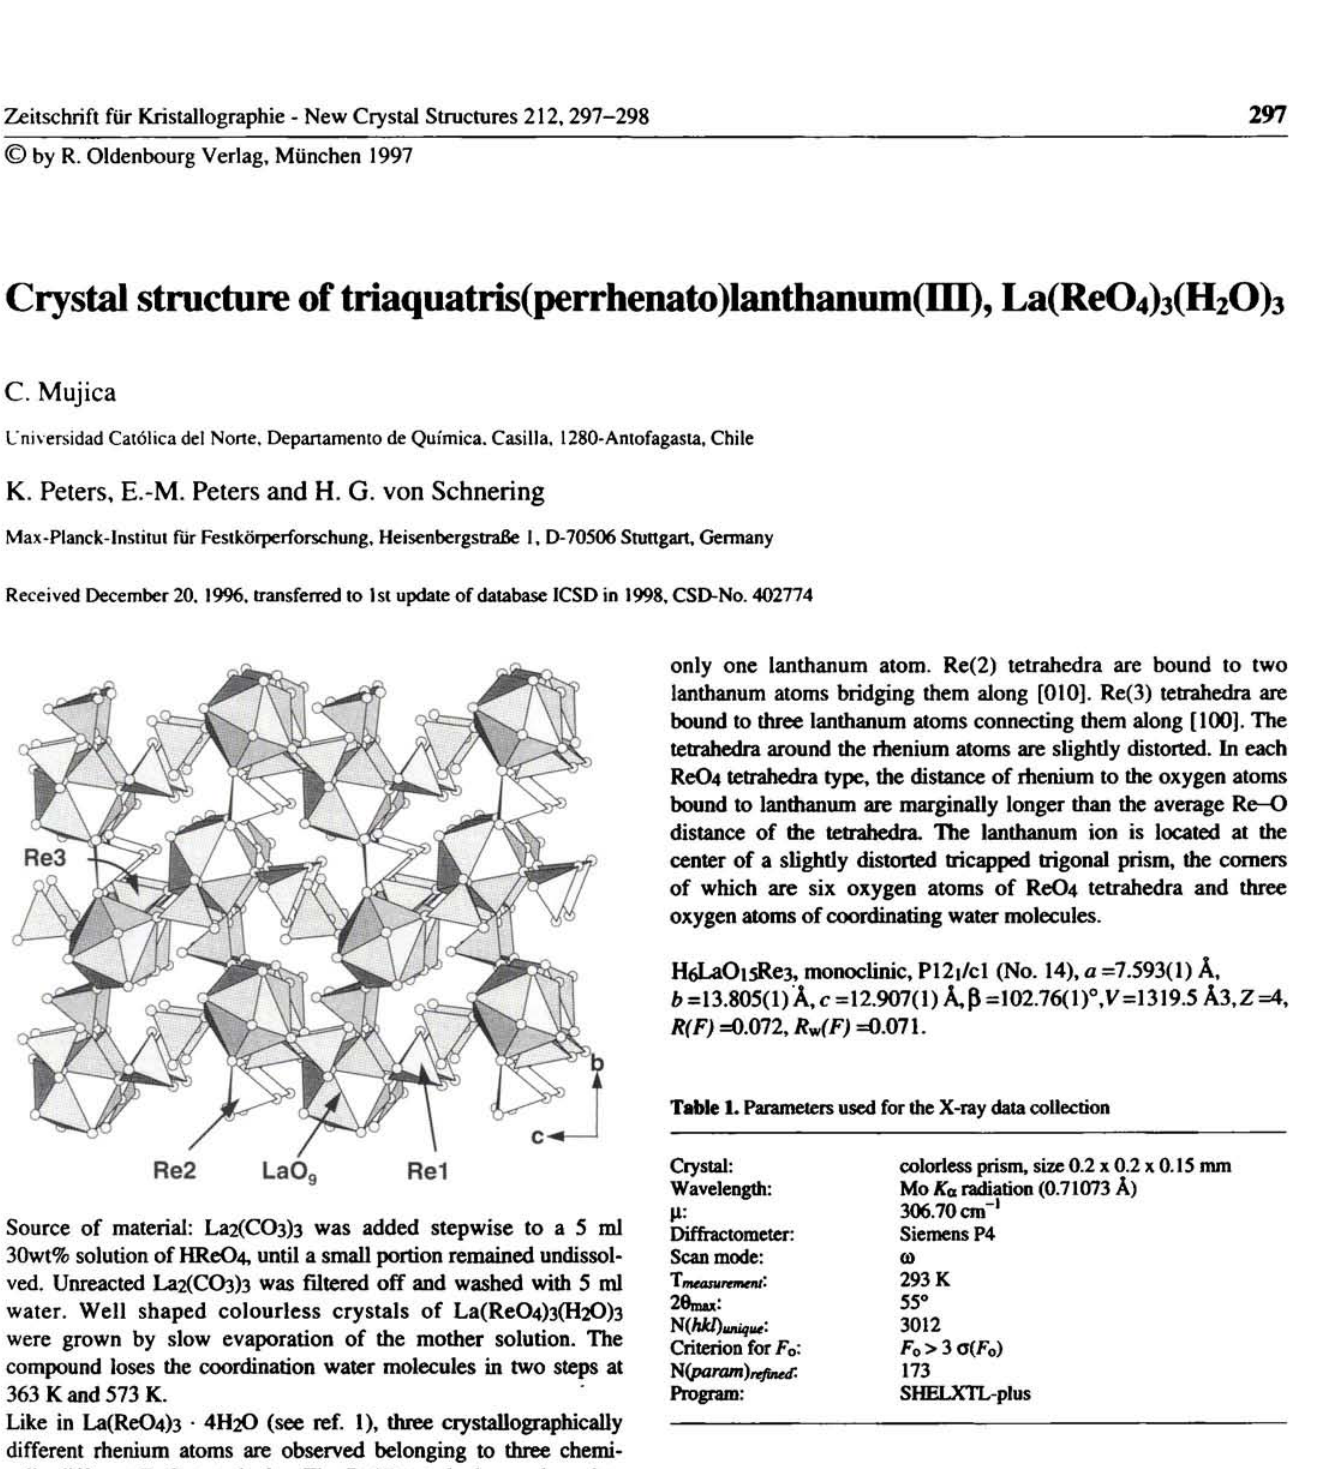
Table 2. Final atomic coordinates and displacement parameters (in Â 2 )